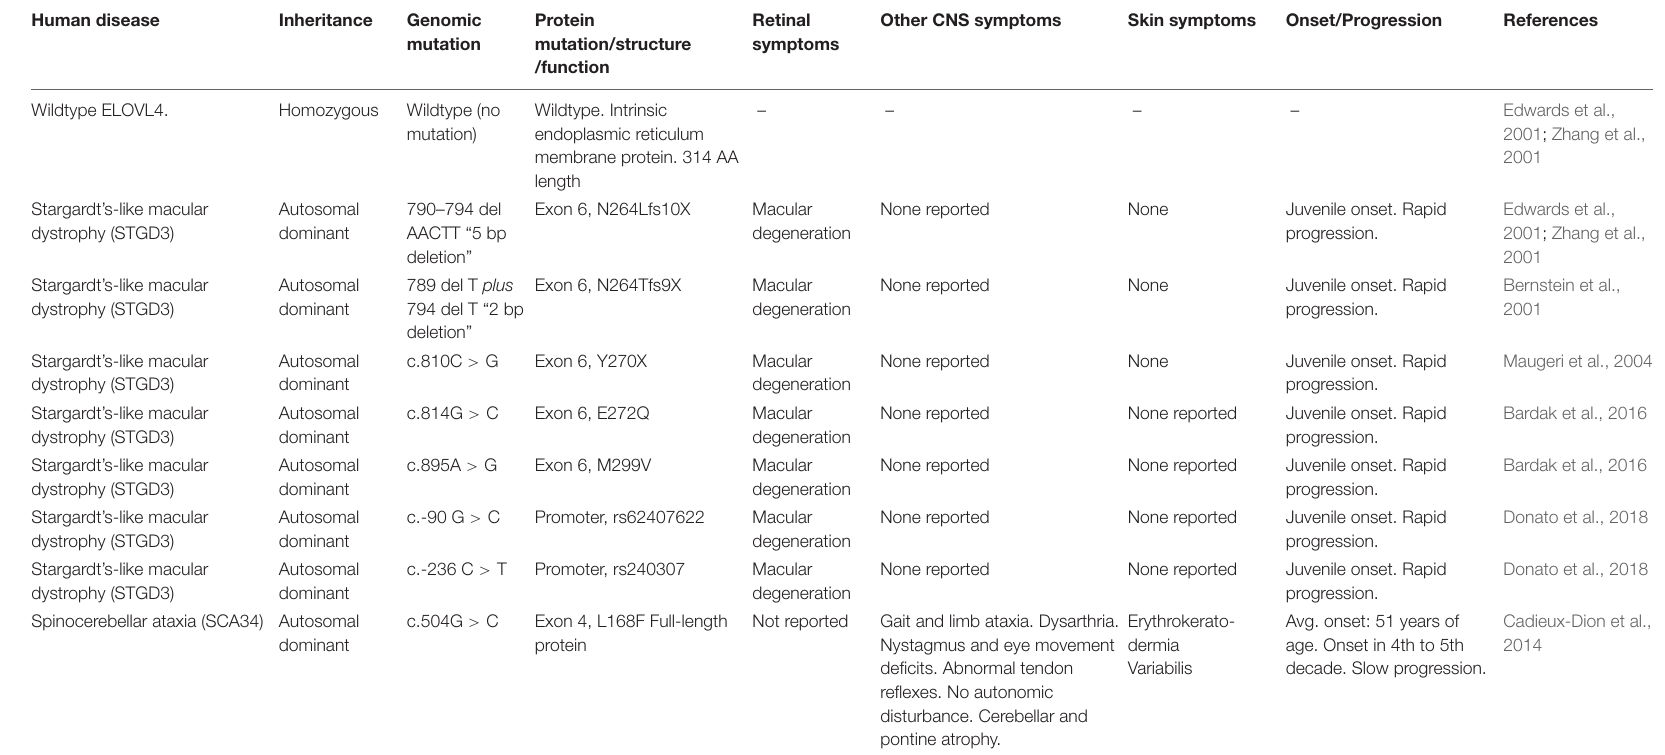
TABLE 1 | Summary of human disease-causing ELOVL4